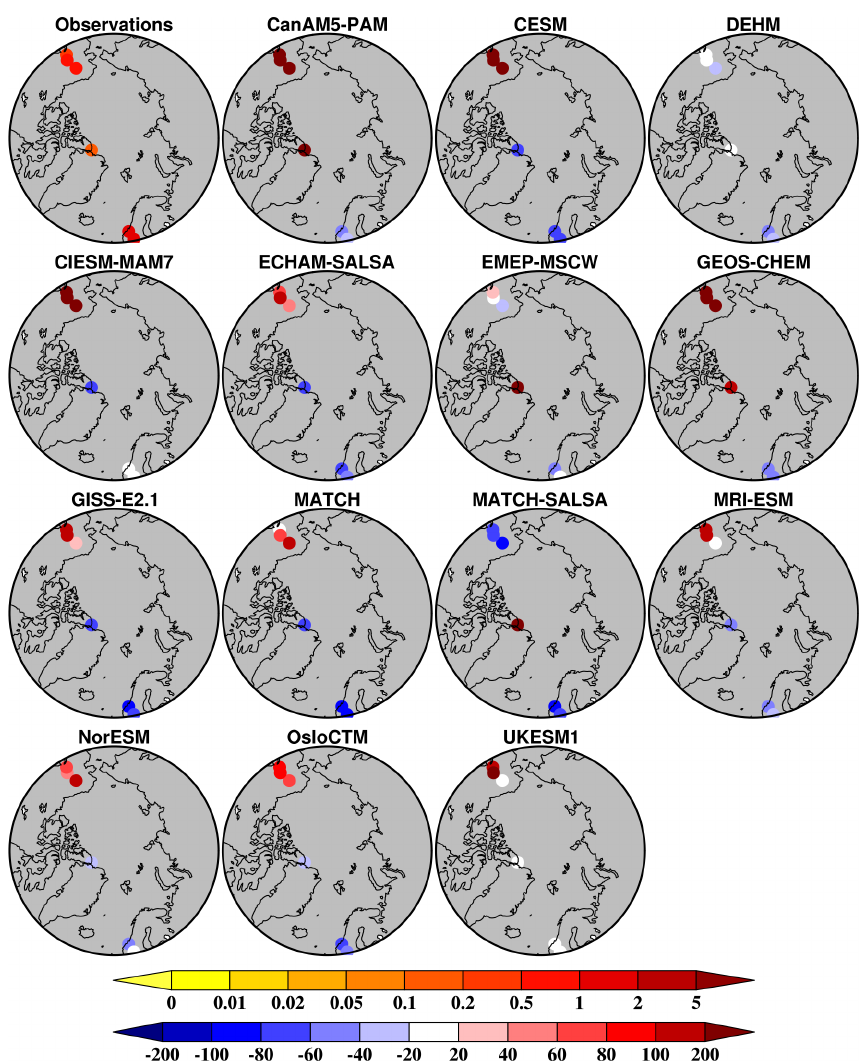
Figure 21. Mean OA concentrations (µgm − 3 , top color bar) at surface Arctic measurement sites and model bias (as model– measurement / measurement in percent, bottom color bar) for 2014–2015. Results from 2008–2009 are similar and not shown.